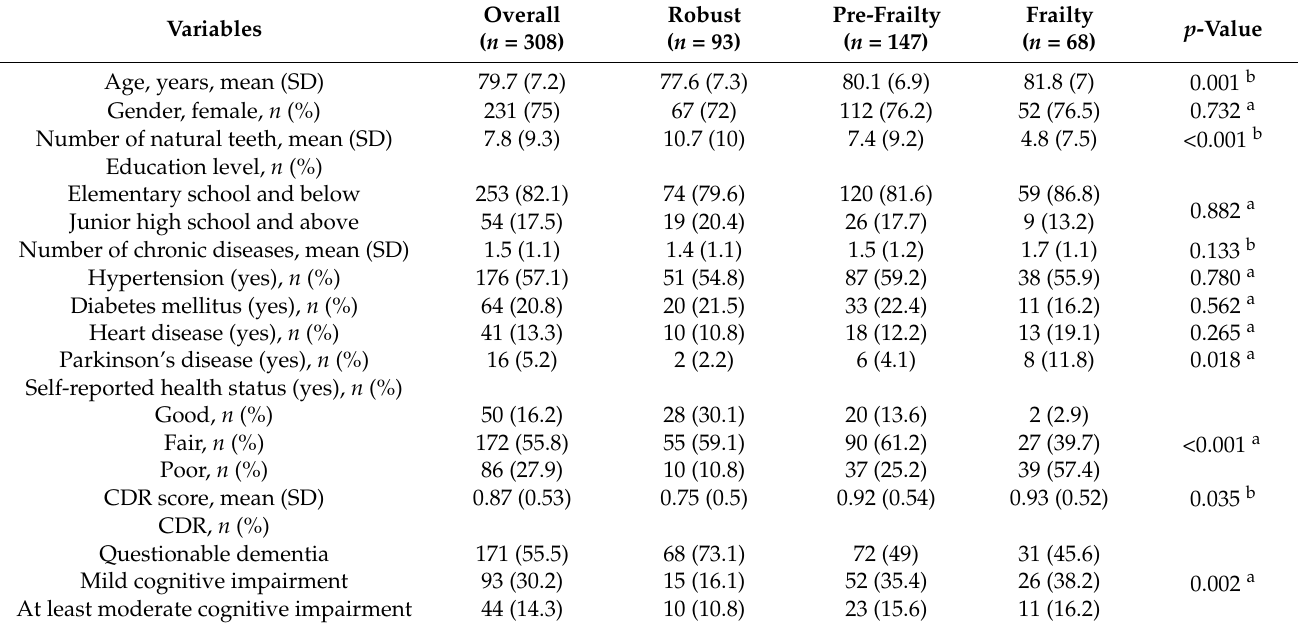
Table 1. Characteristics of study participants stratified by frailty